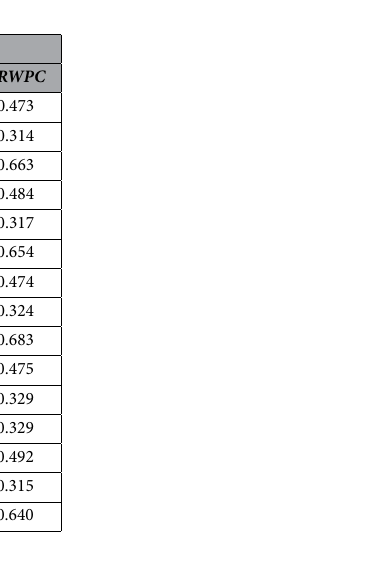
Table 2. The statistical characteristics of hydro-social indicators.